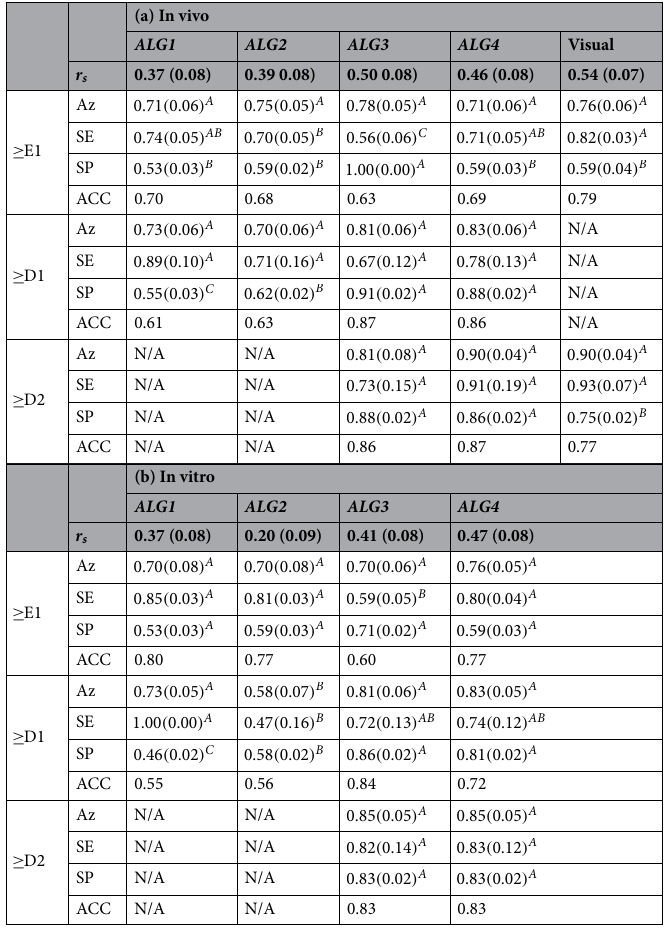
Table 2. Descriptive results for all methods assessed in vivo (a) and in vitro (b). r s , Spearman’s rank correlation coefficient; Az, area under the ROC curve; SE, sensitivity—true positive rate; SP, specificity—true negative rate; ACC, diagnostic accuracy; N/A, not available. Standard error is provided in parenthesis. SE and SP standard error is adjusted for clustered data 32 . The significant differences within the same row are marked with capital letters following the sequence A > B > C . Confidence level was defined at 95% for all statistical